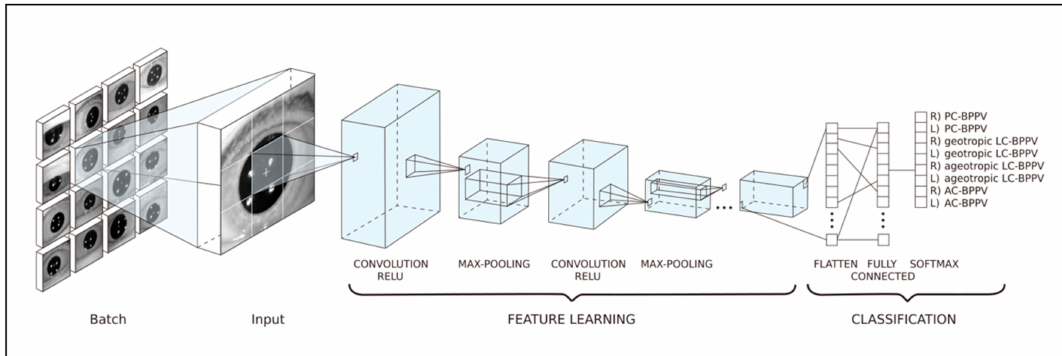
Figure 3. The convolution neural network architecture used to build the model for diagnosing benign paroxysmal positional vertigo (BPPV). From each video, 30 features were extracted using an algorithm to measure eye movement along three axes. These features were used as model inputs. In the model, a convolution layer, a batch-normalization layer, and a rectified linear unit activation layer were sequentially connected. The fully connected layer then employed the softmax function to diagnose BPPV types. (R = right, L = left, PC = Posterior semicircular canal, LC = Lateral semicircular canal, AC = Anterior semicircular